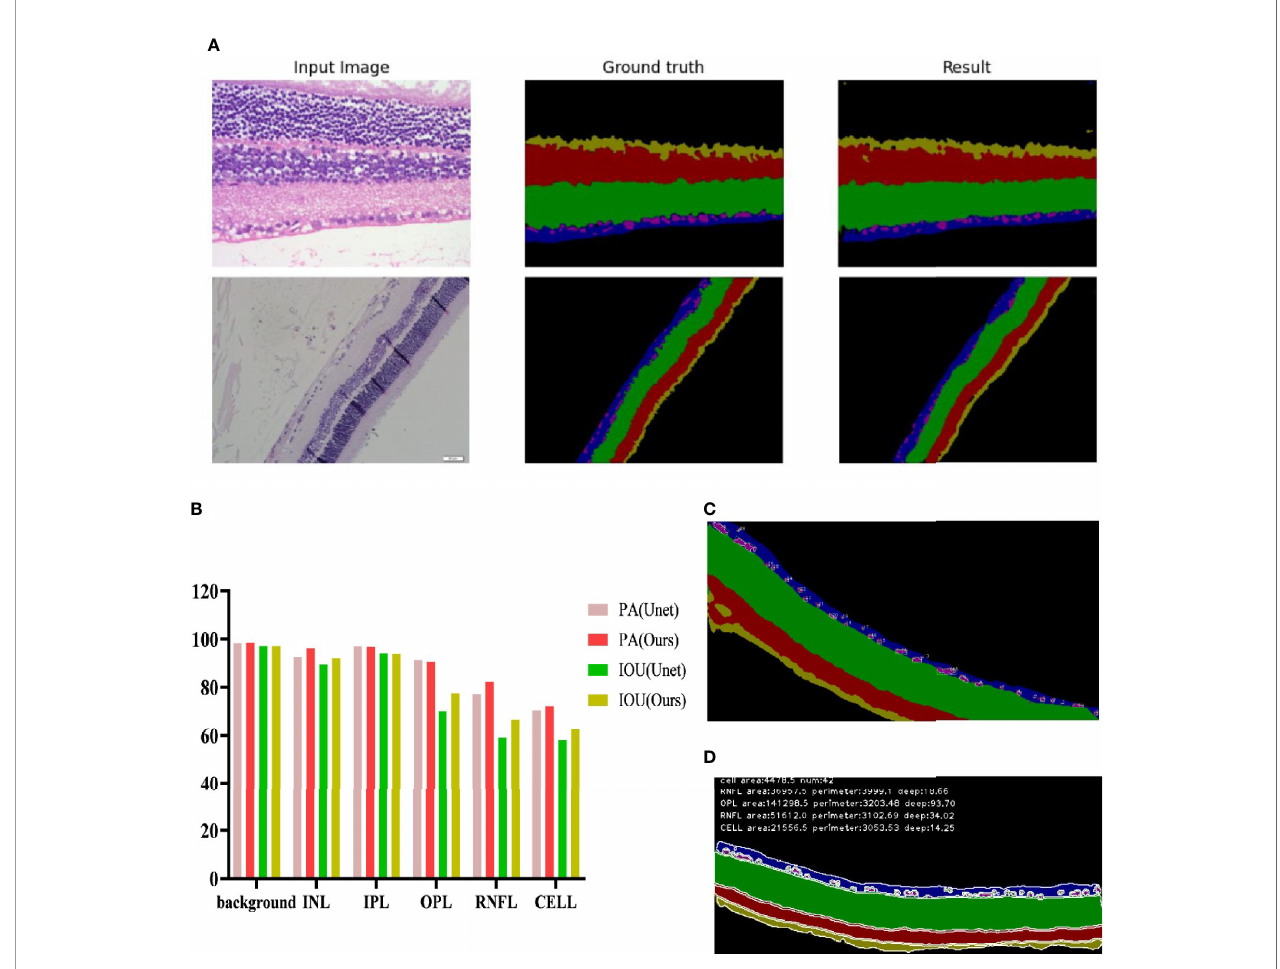
FIGURE 5 | Recognition effect of the Unet network enhanced by full convolutional attention. (A) Input image is the collected HE original image; Ground truth is the output result of manually annotated images; Result is the Unet network output Result of full convolutional attention enhancement. (B) Background is the Background area outside the target area, and CELL is the ganglion CELL, INL is the kernel layer, IPL is the internal layer, OPL is the external network layer, and RNFL is the nerve fi ber layer. PA is pixel accuracy, and IOU is intersection ratio parameter. (C) The segmentation result of corrosion calculation was added to the original algorithm. (D) Segmentation results obtained by the original